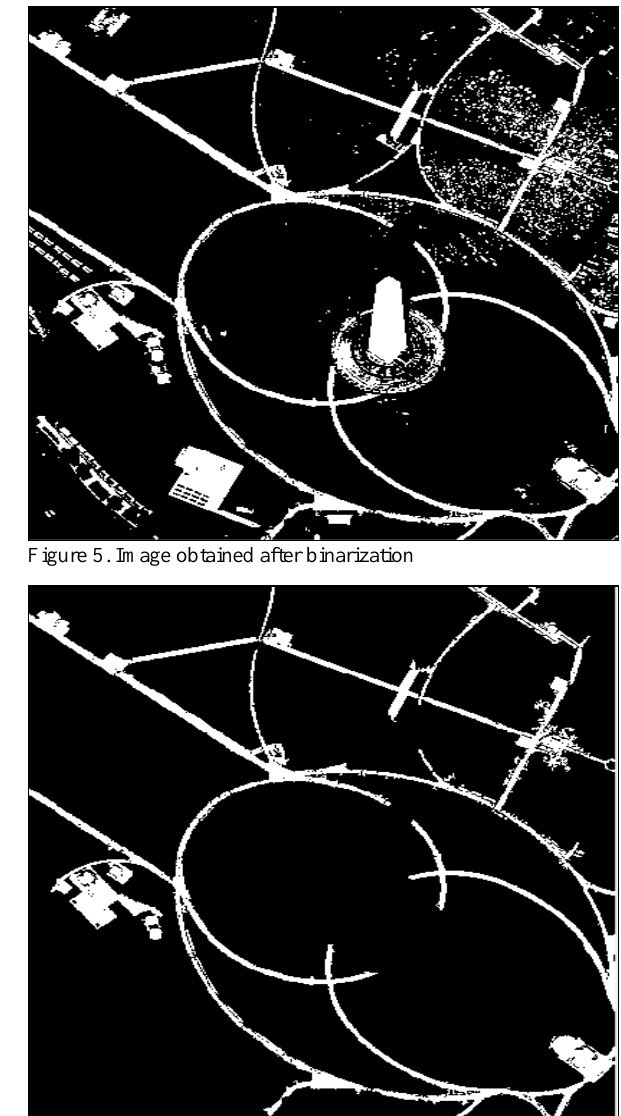
Figure 3. Image obtained after grayscale conversion